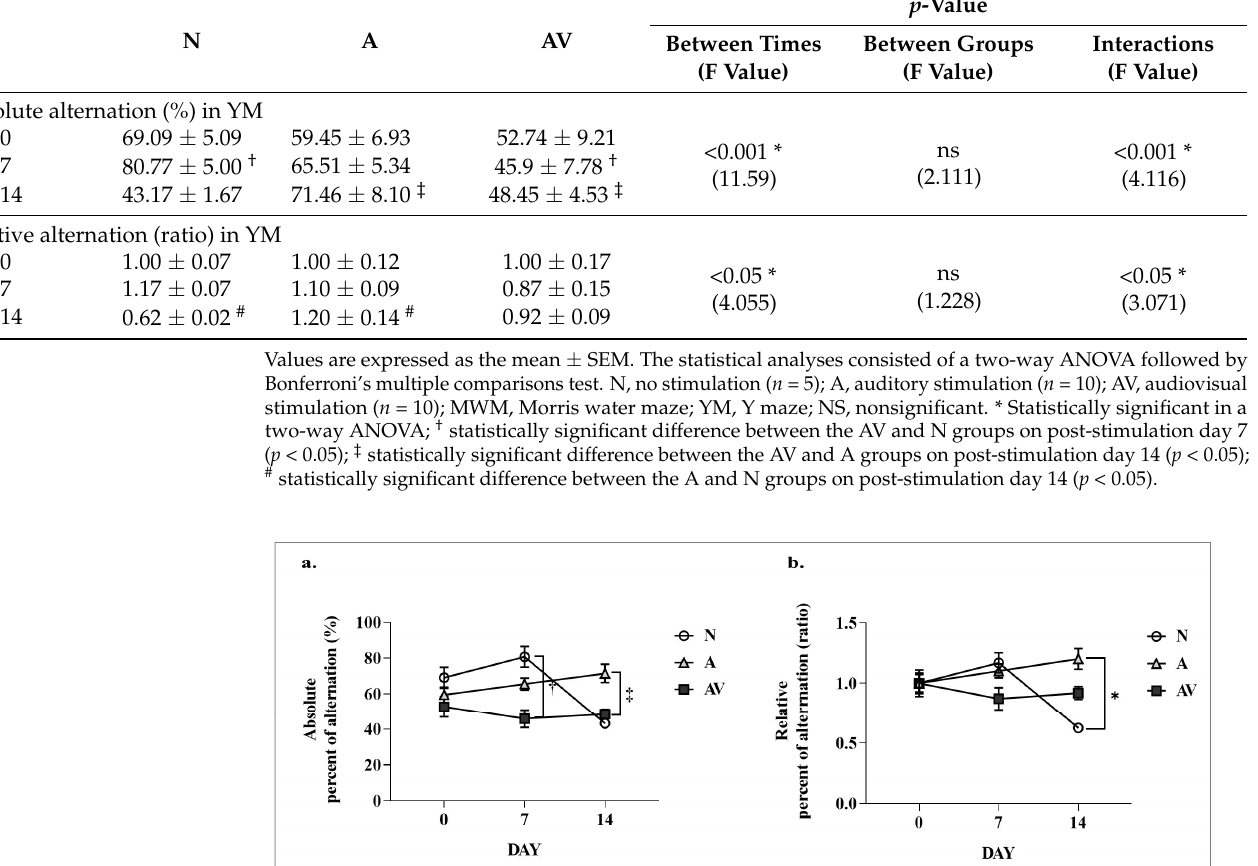
Table 2. Amyloid-beta expression levels in ApoE4-KI mice after auditory and audiovisual stimula- tion. N